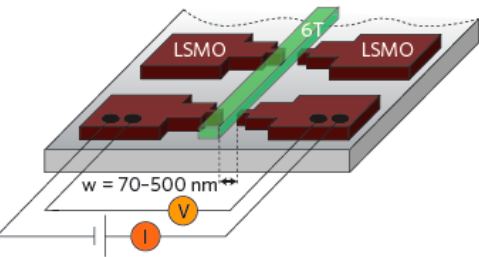
Figure 2. Structure diagram of the LSMO/T6/LSMO sandwich device.